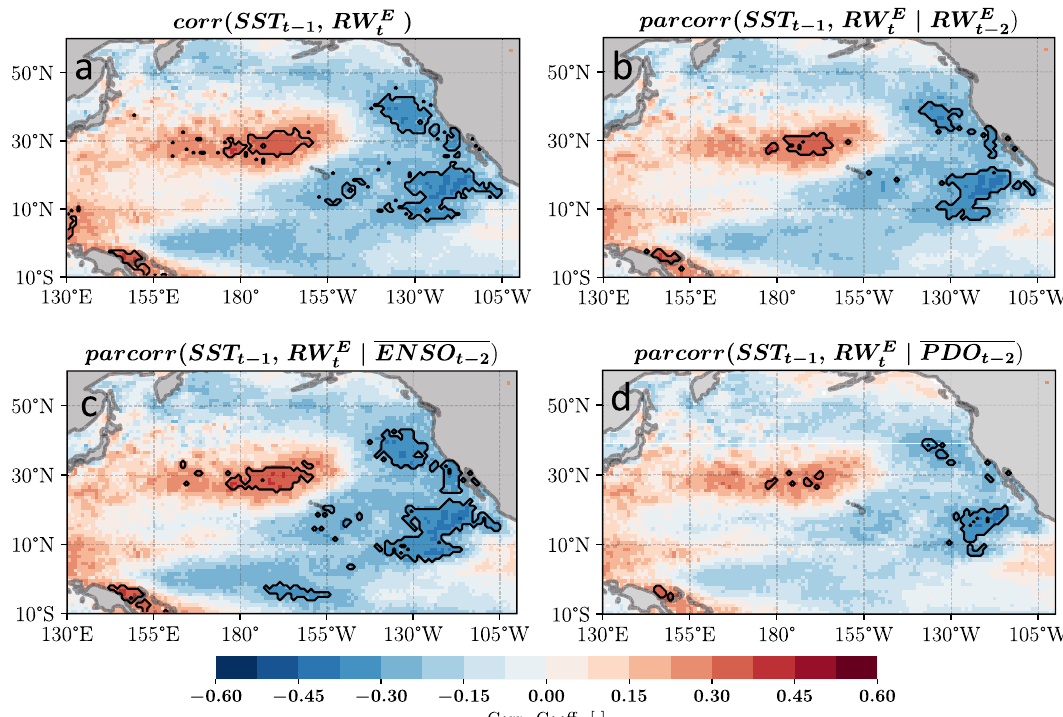
Fig. 4 (Partial) correlation map between SST t -1 and RW E t using 2-month mean data with RW E t de fi ned from May to August. Panel ( a ) shows , whereas panel ( b ), ( c ) and ( d ) show the partial correlation maps that are removing the effect of the correlation map between SST t -1 and RW E t timeseries, the 6-month rolling mean ( c ) ENSO and ( d ) PDO timeseries. The rolling mean is de fi ned at (and prior to) lag 2. ( b ) the RW E t (cid:1) 2 Gridcells are highlighted by contour lines if they are signi fi cant ( α FDR = 0.05) at least 5 out of 10 training subsets. (a) precursors found by the response-guided DR and (b) the PDO done on only training data and extrapolated to the test set to climate index timeseries (Fig. 6). The test data is obtained by make out-of-sample predictions. We use the correlation coef fi cient splitting the data into training and test years using a 10-fold and the Mean Absolute Error Skill Score (MAE-SS) for the strati fi ed cross-validation (see “ Method ” ). Both DR methods are veri fi cation. The latter is de fi ned as MAE (cid:1) SS ¼ 1 (cid:1) MAE forecast